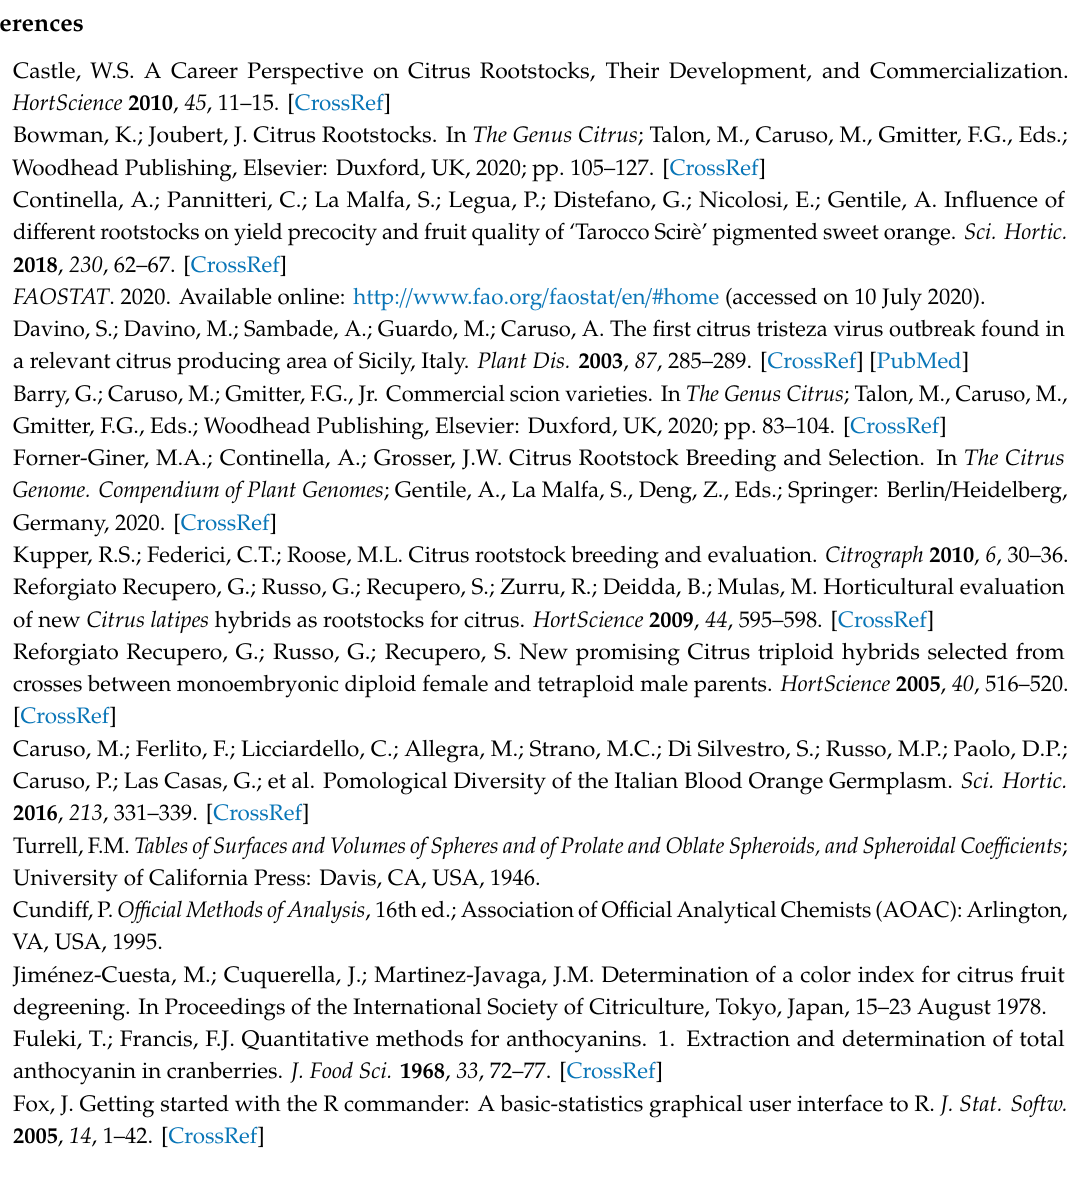
Figure S1: Percentage of fruit drop recorded in 2016, 2017, 2018 and 2019. Di ff erent letters indicate significantly di ff erent means according to Tukey’s test at p <